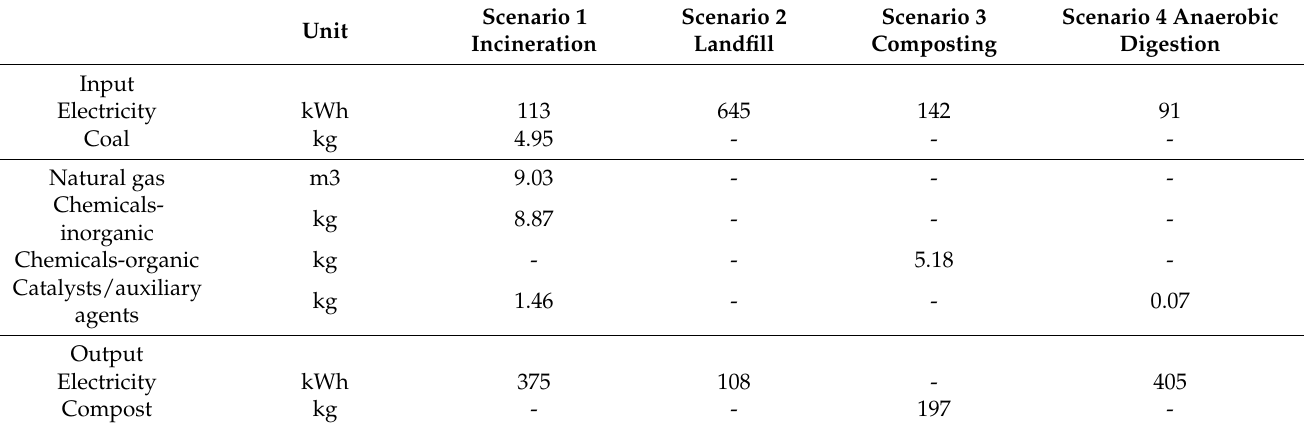
Table 2. Main input and output data at 1 metric ton kitchen waste